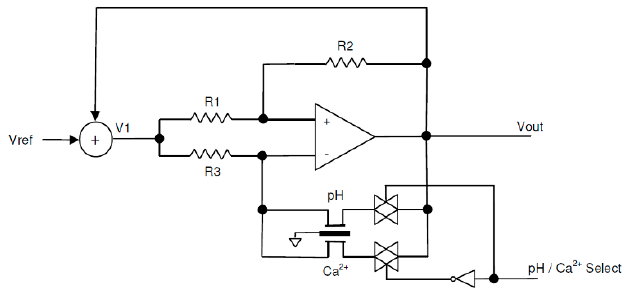
Figure 5. The constant-voltage, constant-current, floating bridge potentiometric readout circuit.